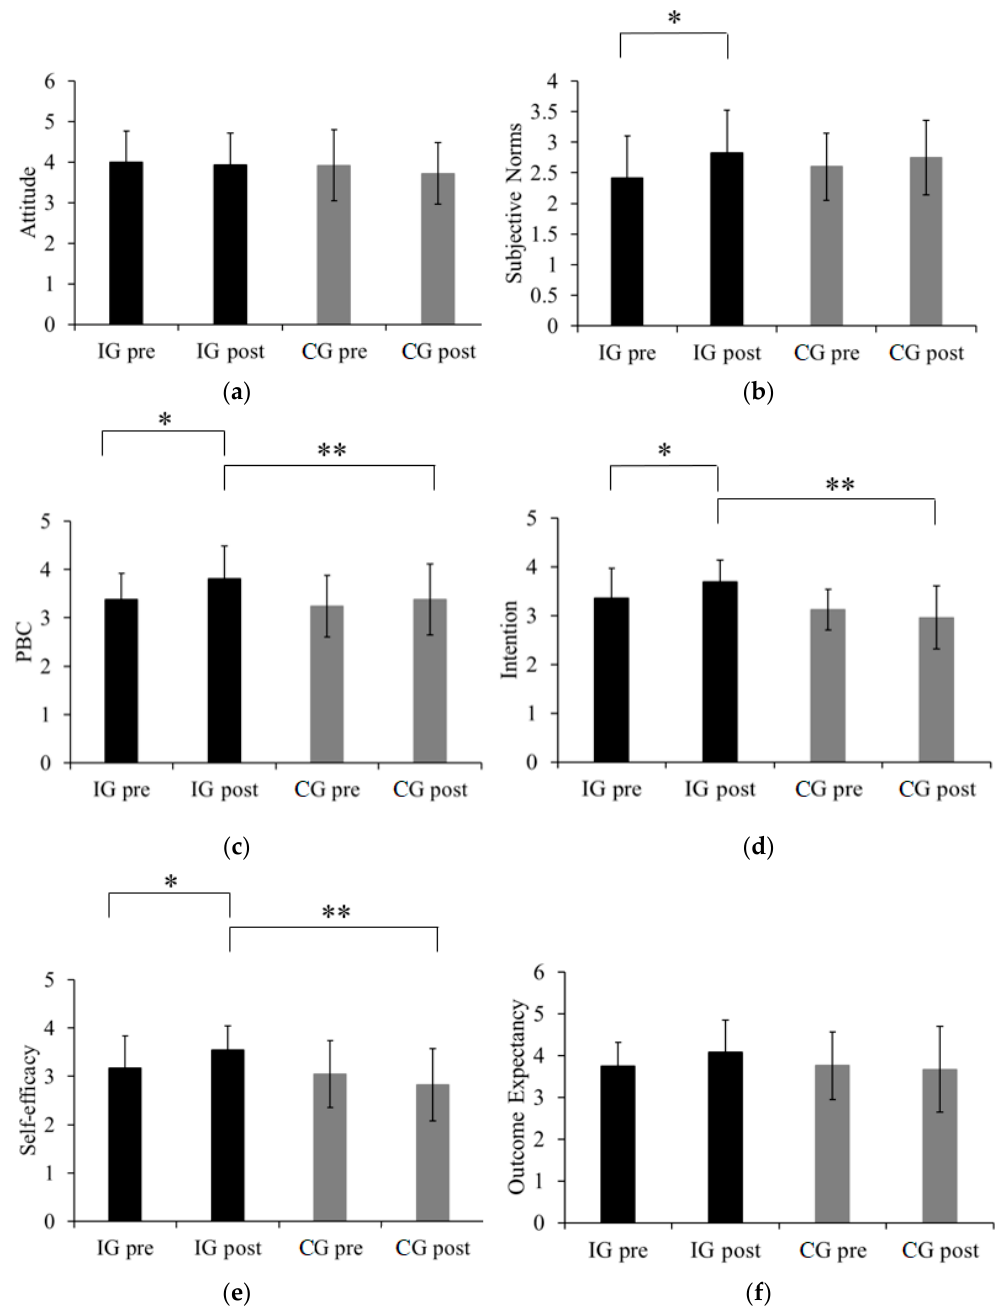
Figure 2. Changes of subjective scores of ( a ) attitude, ( b ) subjective norms, ( c ) perceived behavioral control, ( d ) intention, ( e ) self-e ffi cacy, and ( f ) outcome expectancy regarding physical activity between the two groups from pre-test to post-test. IG pre, pre-test of intervention group; IG post, post-test of intervention group; CG pre, pre-test of control group; CG post, post-test of control group. * Significant within-group di ff erence from pre-test to post-test ( p < 0.05). ** Significant between-group di ff erence at baseline and after intervention ( p <